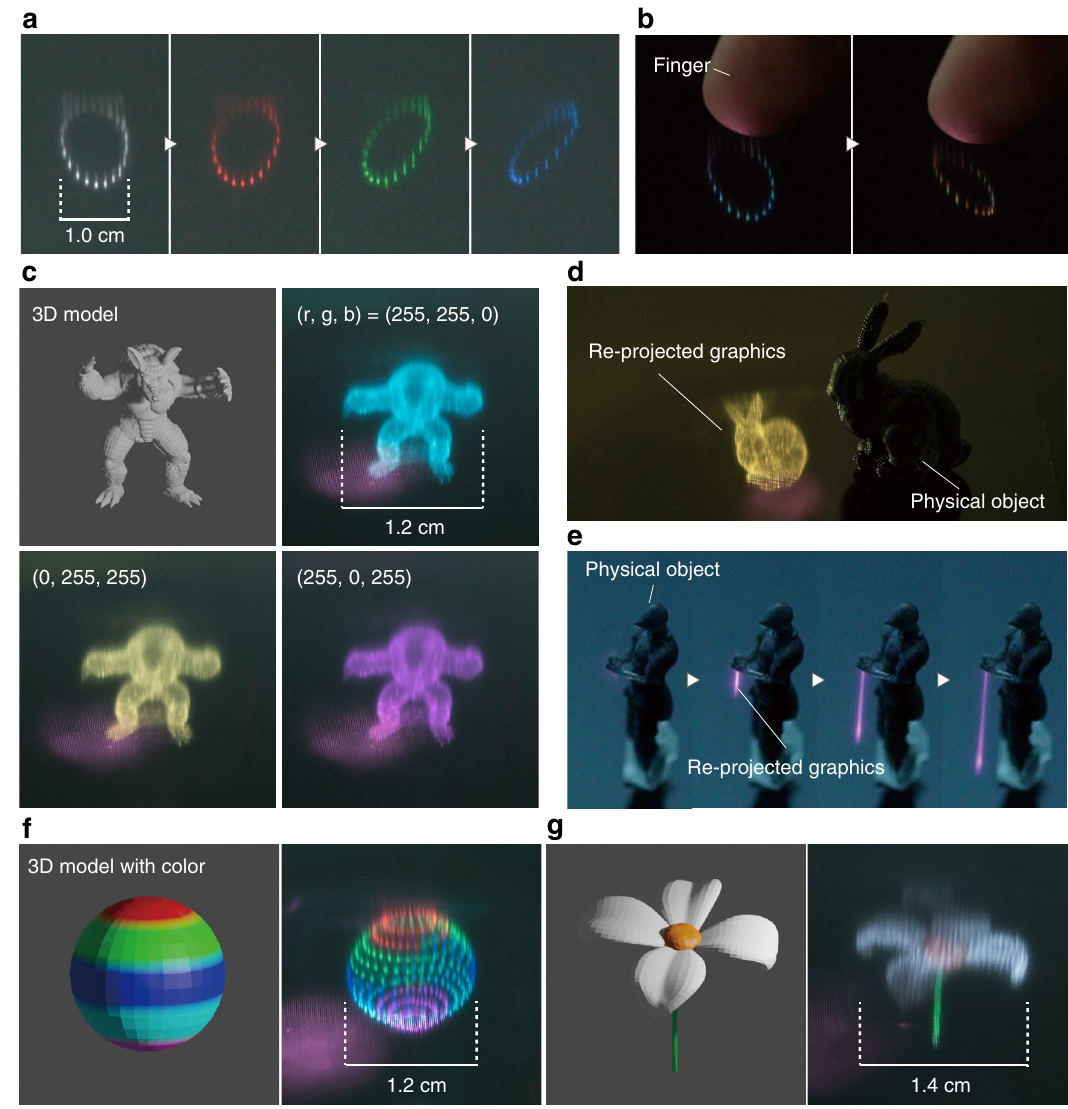
Figure 5. Graphics in a volumetric display based on DSS. A sequence of rotating Lissajous figures with ( a ) three different colors and ( b ) touched by a finger. ( c ) Armadillo and ( d ) Stanford bunny generated beside a physical bunny. These models were provided by the Stanford 3D Scanning Repository (http:// graph ics. stanf ord. edu/ data/ 3Dsca nrep/). ( e ) Physical knight with a light saber. The 3D model of the knight was taken from Knight Statues (https:// www. thing iverse. com/ thing: 41987 05) under the Creative Commons license CC BY 4.0 (https:// creat iveco mmons. org/ licen ses/ by/4. 0/). Images of a ( f ) sphere and ( g ) flower with multicolored voxels. The flower was taken from https:// free3d. com/ 3d- model/ flower- 9941. The femtosecond laser (Micra and Legend Elite Duo, Coherent) has a center wavelength of 800 nm and repeti- tion frequency of 1 kHz with an average power of 7 W. The LCOS-SLM (X13139-02, Hamamatsu Photonics K.K.) supports 1272 × 1024 pixels with a pixel pitch of 12.5 µ m and is driven by an 8 bit signal with a refresh rate of about 10 Hz. The polarization direction of the laser incident on the LCOS-SLM was aligned with the orientation of the LC to obtain the maximum diffraction efficiency. The 3D beam scanner was composed of a galvanometer scanner (GM-1010, Canon) and a varifocal lens (EL-16-40-TC-VIS-5D-C, Optotune). The galvanometer scanner has an available beam deflection angle of 40 ◦ and enables the scanning of focal points in the horizontal direction. The varifocal lens has an aperture of 16 mm and variable focal length region of − 500 to + 333 mm, which allowed us to control the axial position of the focal point. The LC color filter was placed immediately after the aperture of the parabolic mirror on the re-projected graphics side and can switch the filter color. A Xe-filled cylindrical glass cell with a diameter and height of 30 mm was employed as a drawing space.